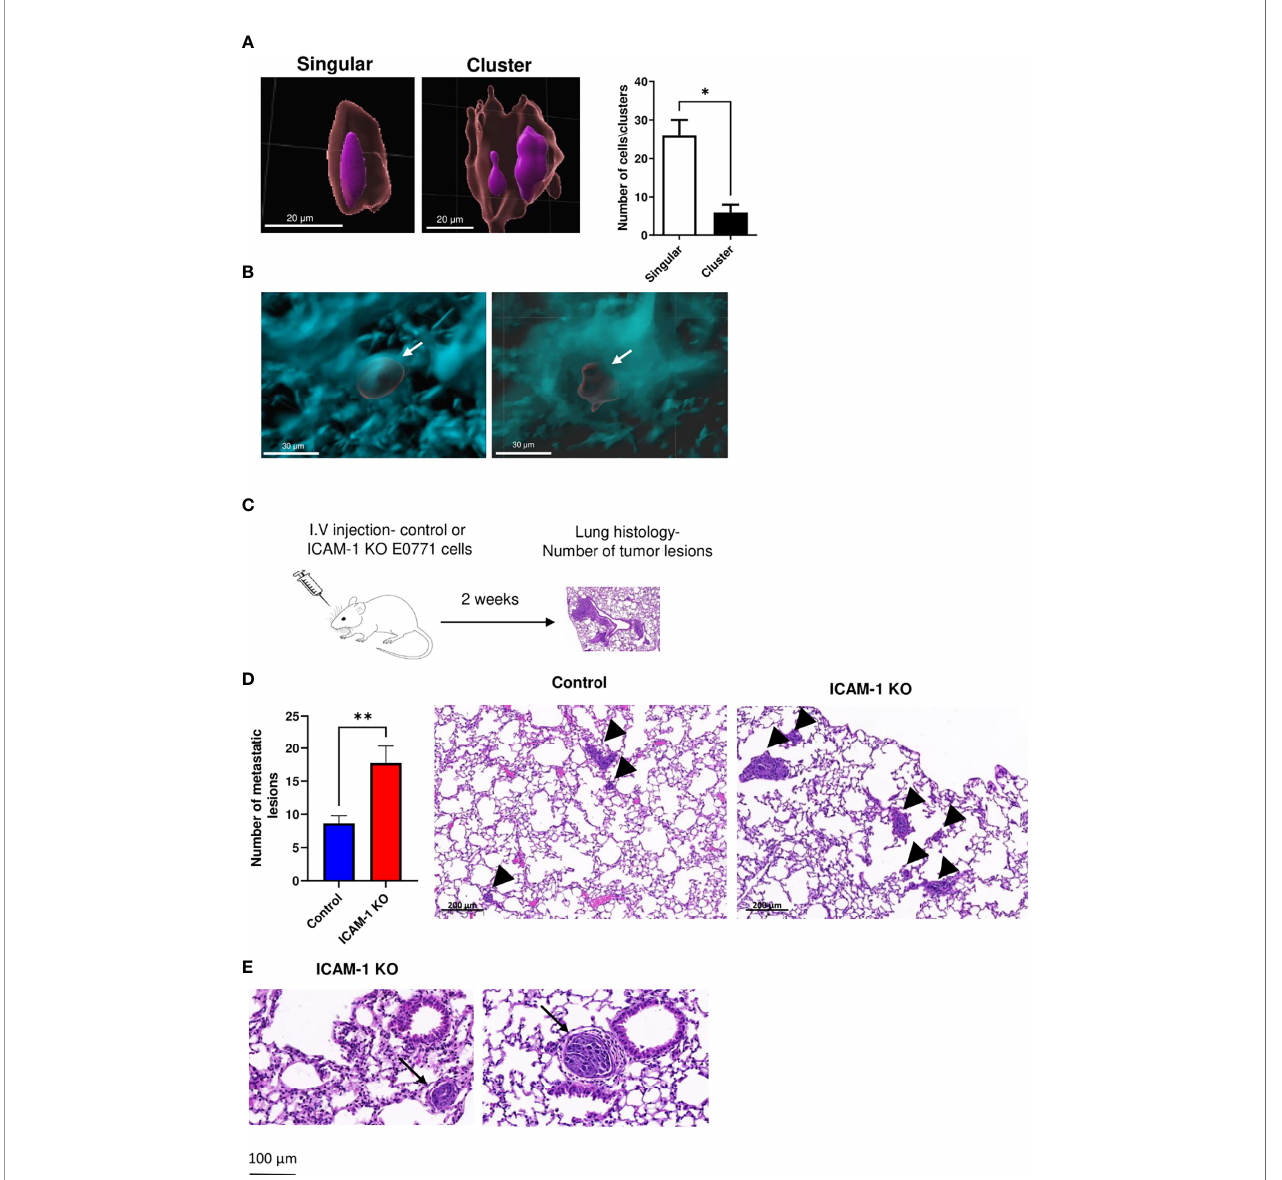
FIGURE 6 | E0771 breast cancer ICAM-1 suppresses experimental metastasis to lung. (A) Visualization of singular and clustered E0771 cells accumulated inside lungs imaged by LSM. 1 × 10 4 WT E0771 cells were injected i.v. Nuclei were labeled with REEDOT1. Nuclei (purple) and CMTMR-labeled E0771 breast cancer cells (red) were imaged by the LSM of cleared lungs lobes as outlined in Figures 4 , 5 . Bars = 20 µm. The right panel depicts the number of single cells and clusters detected in each imaged lung cube as in Figures 4 , 5 . The left lobes of two mice were imaged. The bars depict the mean values ± SEM. (B) LSM images of cleared lungs labeled with anti-CD31 mAb as in Figures 4 , 5 , 1 h postinjection of 1 × 10 4 CMTMR-labeled E0771 cells (left panel) or 2 weeks postinjection of 10 4 RFP E0771 (right panel). (C) A scheme of the experimental metastasis model. Approximately 10 4 control or ICAM-1 KO E0771 cells were injected i.v., and 14 days later, lungs were harvested and the number of E0771 lesions was determined by the H&E staining of 5-µm-thin lung sections. (D) Left panel: The number of metastatic lesions detected in 100 lung sections of 20 mice. A total of 5 lung sections 100 m m apart were isolated from the left lung lobe of each recipient mouse. The bars depict the mean values ± SEM. ** p <0.005. The right panel depicts the representative histological sections of the two different experimental groups. The arrowheads depict either small or large lesions. (E) H&E staining of the representative lung sections of lung lobes containing ICAM-1 KO lesions. The arrows depict intravascular lesions in small (left) and large (right)